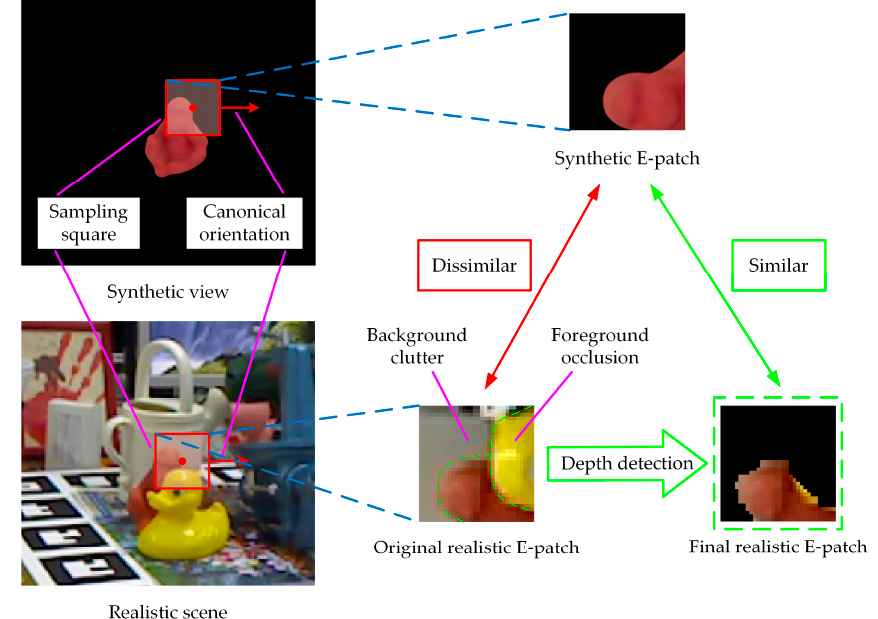
Figure 4. Illustration of the depth-detection process.